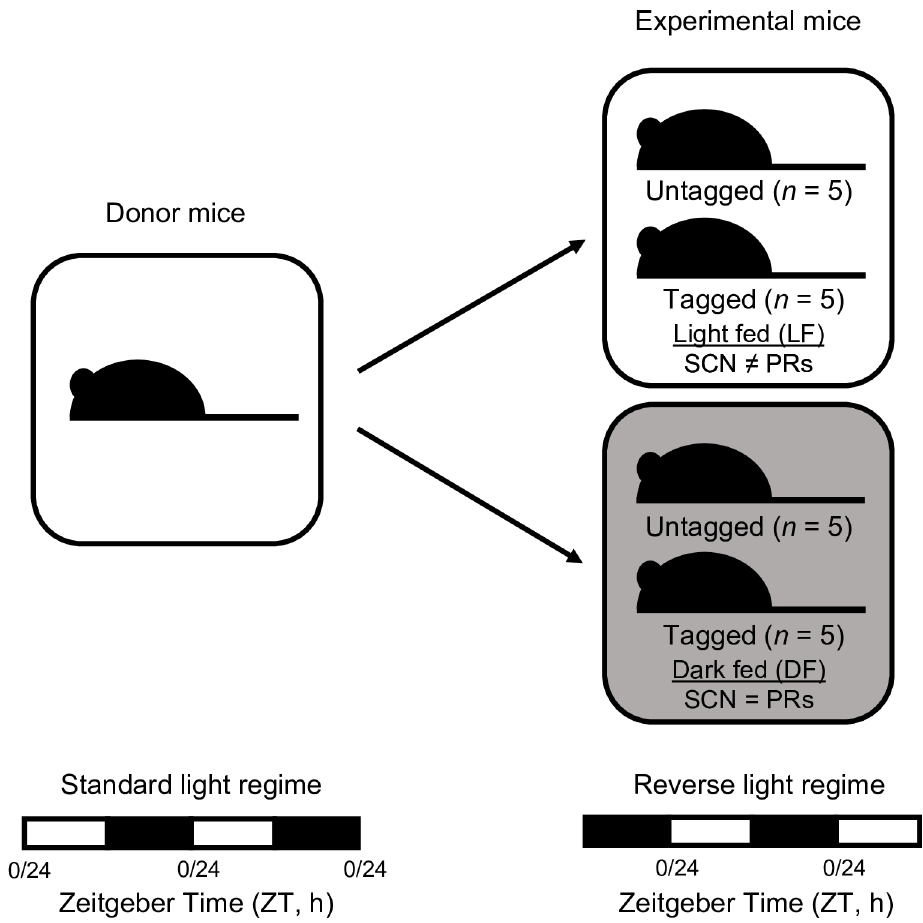
Fig 1. Experimental design, feeding time. Infections were initiated with parasites raised in donor mice entrained to a standard light regime [lights on: 7am (ZT 0/24) and lights off: 7pm (ZT 12)] and used to create experimental infections in hosts entrained to a reverse light regime of 12-hours light: 12-hours dark [lights on: 7pm (ZT 0/24), lights off: 7am (ZT 12); ZT is Zeitgeber Time: hours after lights on], leading to a 12-hour phase difference in SCN rhythms of donor and host, and subsequently, parasite infections (see Materials and Methods for the rationale). Hosts were then assigned to one of the two treatment groups. One group (N = 10) were allowed access to food between ZT0 and ZT12 (“light fed mice”, LF, food access during the day) and the other group (N = 10) allowed access to food between ZT12 and ZT0 (“dark fed mice”, DF, food access during the night). Body temperature and locomotor activity were recorded from a subset of RFID “tagged” mice in each group (N = 5 per group). Changing feeding time (day time feeding of nocturnal mice) desynchronises rhythmic outputs from the central (SCN) oscillator and the peripheral (peripheral rhythms, PRs) oscillators (“SCN 6¼ PRs”), whereas the SCN and peripheral rhythms remain synchronised in mice fed at night (“SCN =